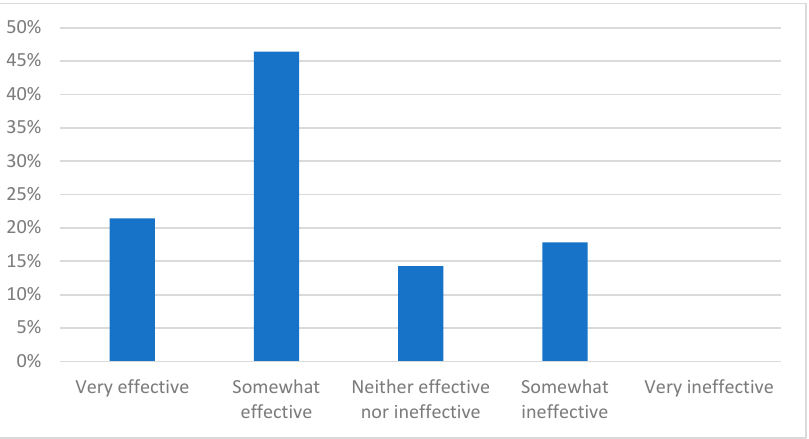
Figure 13. How effective have shipping companies been in adapting to the new norm due to the COVID-19 Pandemic? ( a ) Europe; ( b ) Asia.